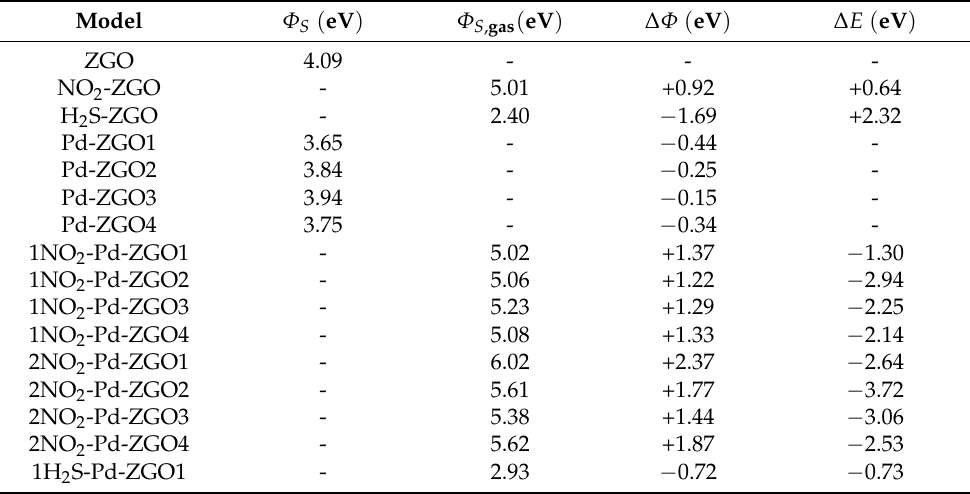
Table 2. Calculated work functions Φ S and Φ S ,gas , work function differences ∆ Φ , and adsorption energies ∆ E for the ZGO surfaces, NO 2 and H 2 S molecules on ZGO surfaces, Pd-adsorbed ZGO surfaces, and NO 2 /H 2 S on Pd-adsorbed ZGO surfaces.